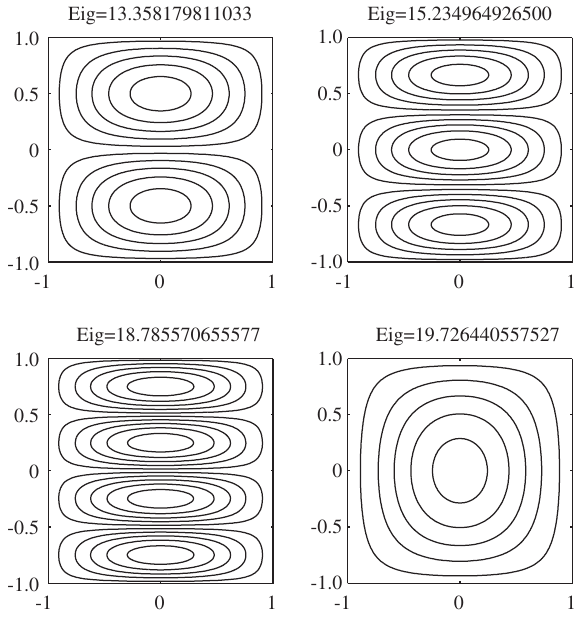
Figure 6 First four buckling modes for a bi-axial buckling load of three-layer [0/90/0] SCSC laminated plate, using a 17 2 points grid and the higher-order